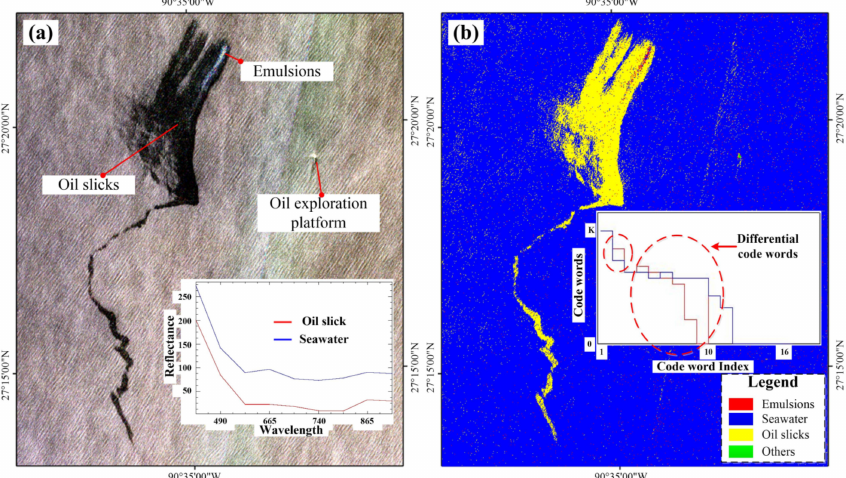
Figure 7. The experimental data 3 (( a ), captured by the Sentinel-2A satellite) and its crude oil leakage detection results produced by the MSE method with SSI ( b ). Differential code words could be observed in the red circle.